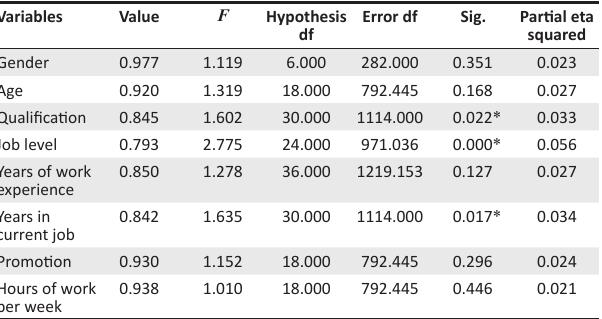
TABLE 4: Multivariate analyses of variance between organisational talent culture and demographics.